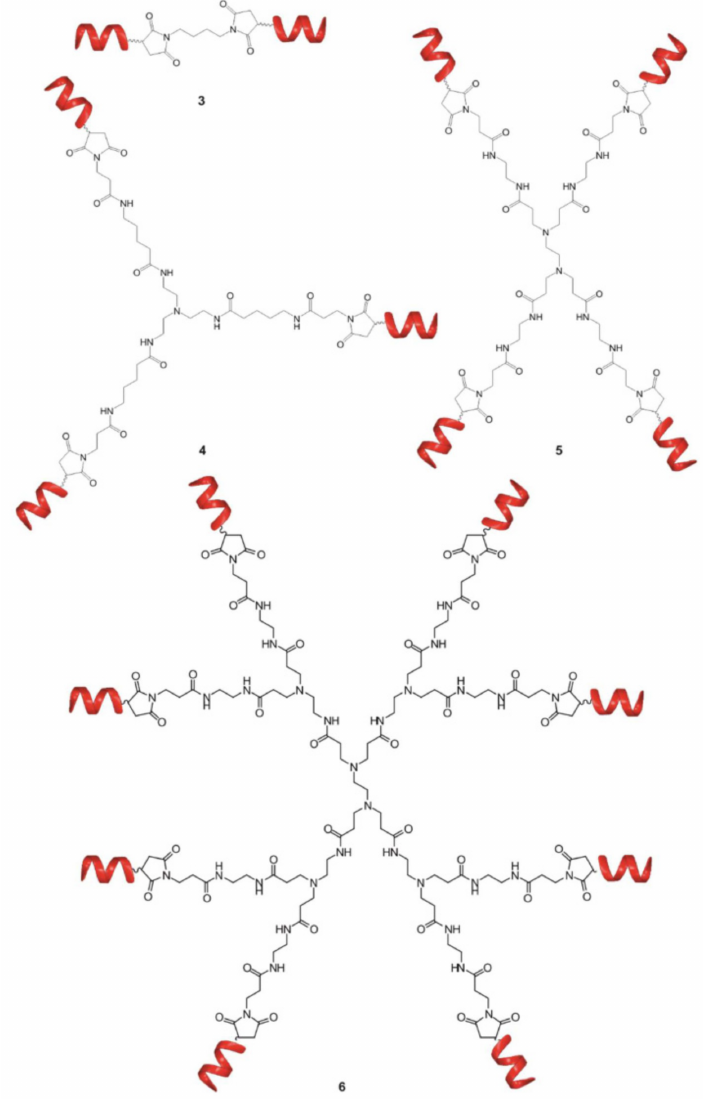
Figure 7. Schematic representation of bivalent (3), trivalent (4), tetravalent (5) and octavalent (6) foldameric conjugates used to study the binding affinities to A β oligomers. Reprinted with permission from ref. [160]. Copyright 2018,